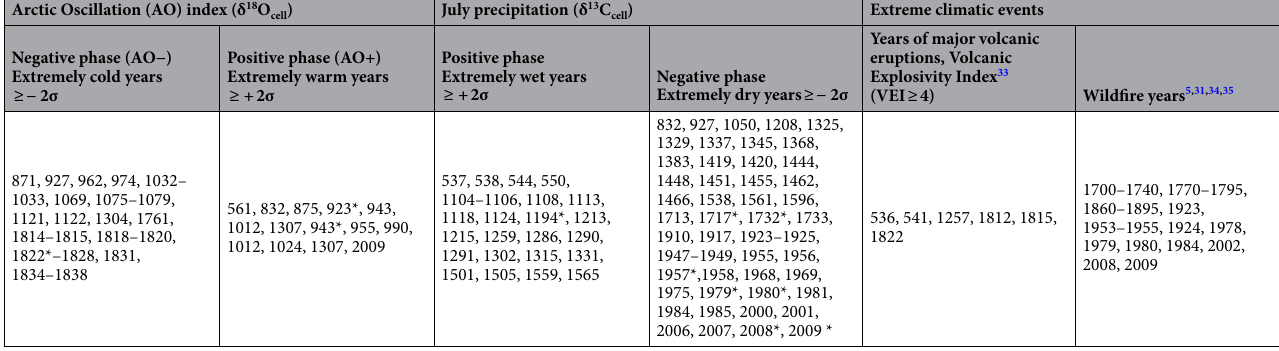
Table 1. Warm and cold extremes were reconstructed based on the δ 18 O cell for Arctic Oscillation (AO) in Mai positive (AO+) and negative (AO−) phases respectively. Extremely dry and wet years of July precipitation were derived from the δ 13 C cell chronology from Taimyr Peninsula over the past 1494 years. As reference major volcanic eruptions with volcanic explosivity index 33 (VEI ≥ 4) and wildfires reported from other studies 5,31,34,35 were considered. Extrem years (≥ − 3σ) are marked as